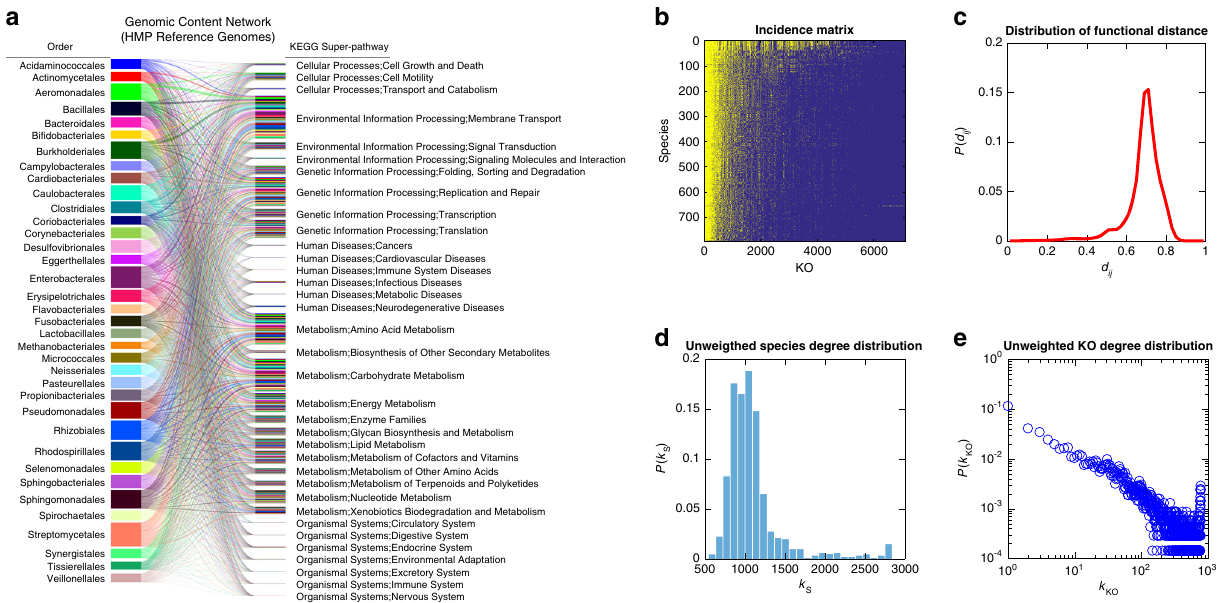
Fig. 2 The genomic content network (GCN) constructed from the Integrated Microbial Genomes and Microbiome (IMG/M) database has nested structure and heterogeneous gene degree distribution. We use IMG/M-HMP, an IMG/M data mart that focuses on the Human Microbiome Project (HMP) generated metagenome data sets 29 to construct the GCN. a For visualization purpose, we depict this reference GCN at the order level for taxon nodes and at the KEGG super-pathway level for function nodes. The bar height of each order corresponds to the average genome size of those species belonging to that order. The thickness of a link connecting an order and a KEGG super-pathway is proportional to the number of KOs that belong to that super-pathway, as well as the genomes of species in that order. The majority of the super-pathways shown here are related to the metabolic, environmental, and genetic processes performed by microbes. However, for a small number of taxa, as some of their genes have mammalian and/or human disease orthologs, we also identi fi ed several super-pathways involved in human diseases and higher-order organizational systems. See Supplementary Sec. 2.1 for the details of constructing this reference GCN. b The incidence matrix of this reference GCN is shown at the species-KO level, where the presence (or absence) of a link between a species and a KO is colored in yellow (or blue), respectively. We organized this matrix using the Nestedness Temperature Calculator to emphasize its nested structure 31 . The nestedness value ( ∼ 0.34712) of this network is calculated based on the classical NODF measure 32 (see Methods for details). c The probability distribution of functional distances ( d ij ) among different species. The bin size is 0.02. d The unweighted species degree distribution. Here, the unweighted degree of a species is the number of distinct KOs in its genome. e The unweighted KO-degree distribution. Here, the unweighted degree of a KO is the number of species whose genomes contain this